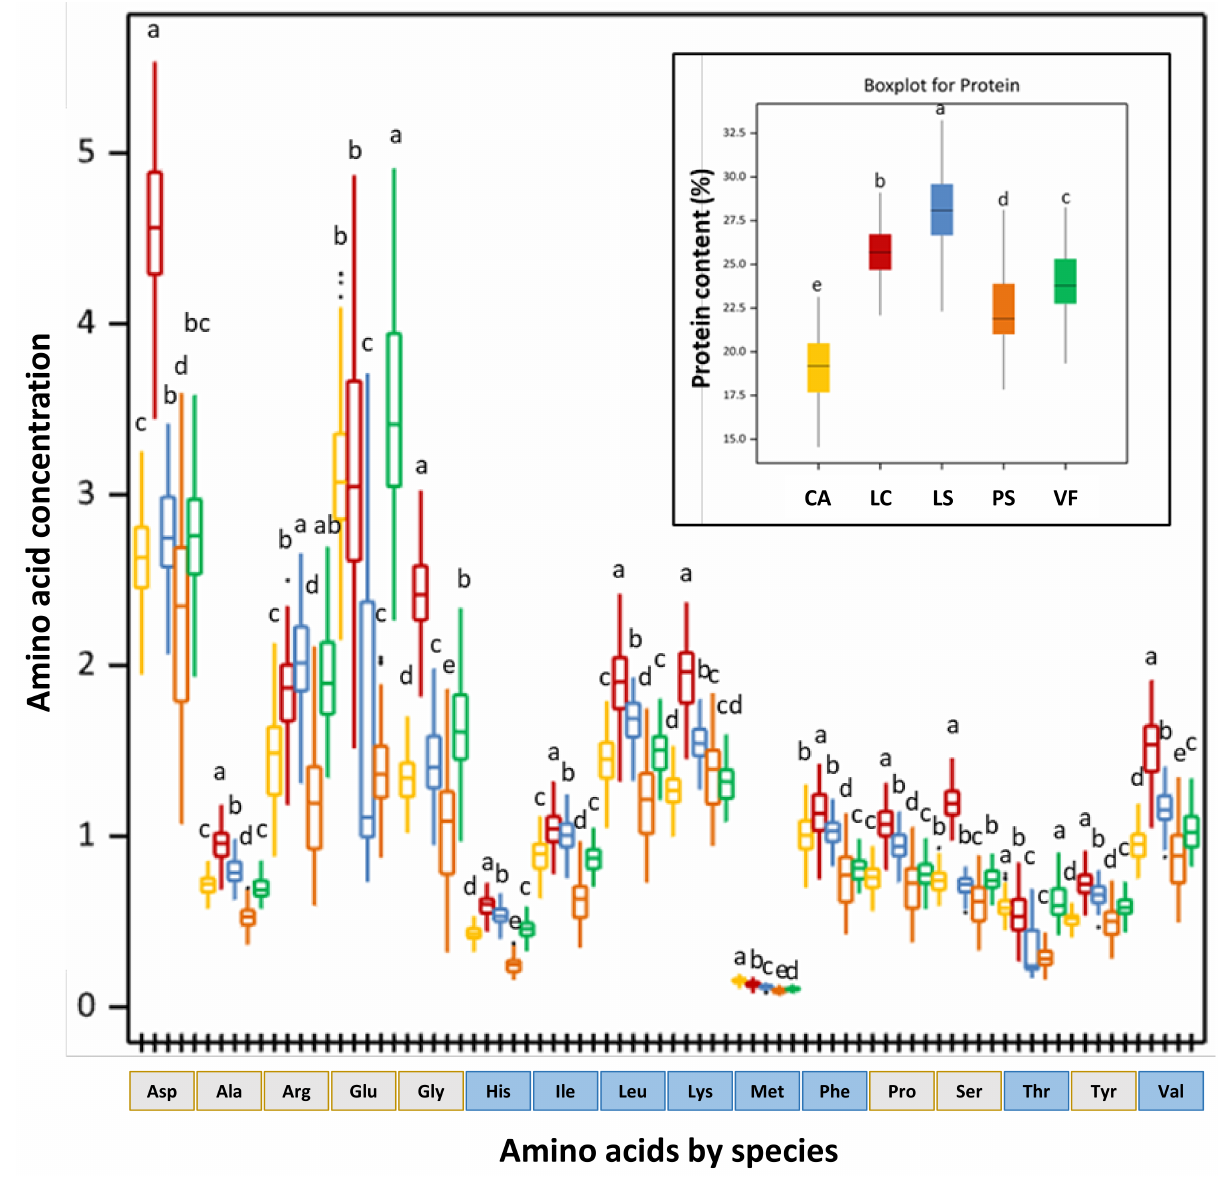
Figure 1. Box plots comparing the results obtained for protein quantity and quality from five grain legume species. Above each box plot, the letters correspond to the result of the species means comparison using a Tukey–Kramer multiple comparisons test; levels that are not significantly different from each other are represented with the same letter. Legend: in yellow, Cicer arietinum (CA), n = 86; in red, Lens culinaris (LC), n = 92; in blue, Lathyrus sativus and their crop wild relatives (LS), n = 109; in orange, Pisum sativum and their crop wild relatives (PS), n = 118; and in green, Vicia faba